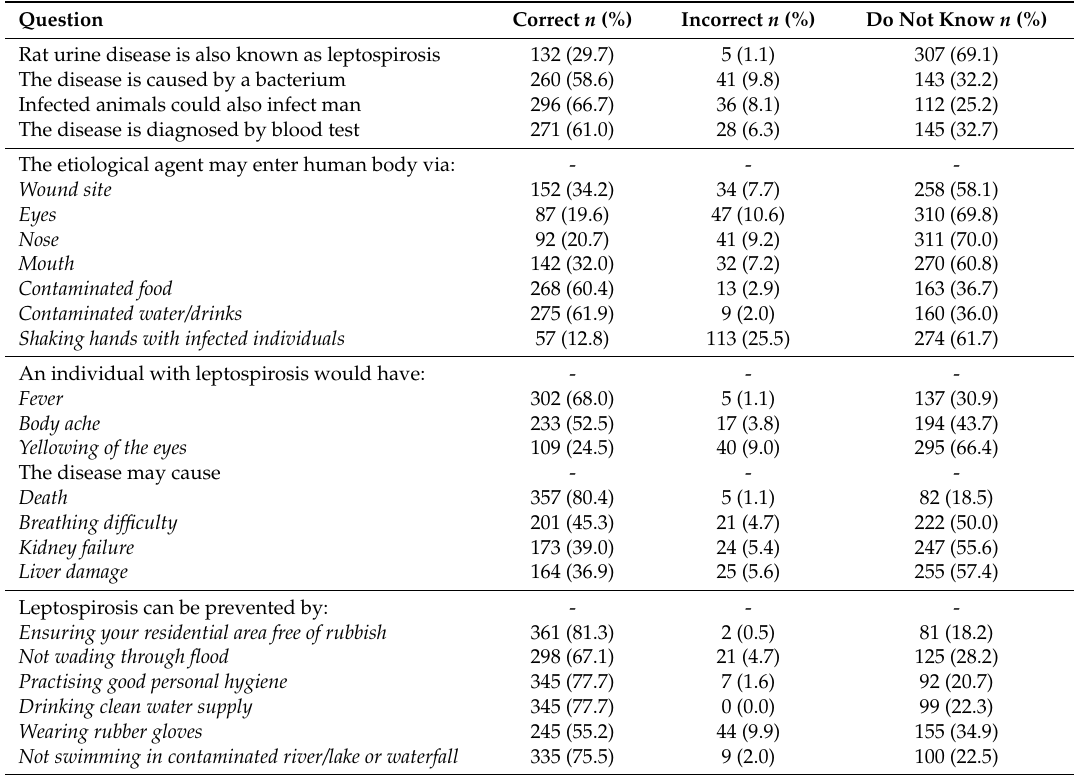
Table 1. The knowledge of leptospirosis by participants in rural areas of Hulu